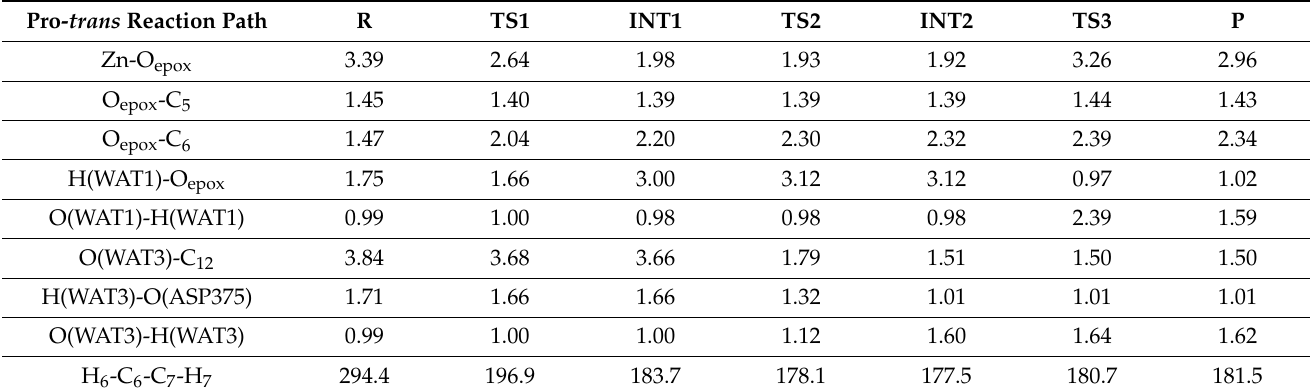
Table 2. Most relevant distances (in Å) and dihedral angle (in degrees) defining the E / Z character of the C 6 -C 7 bond for the stationary structures of the pro- trans reaction path catalysed by LTA 4